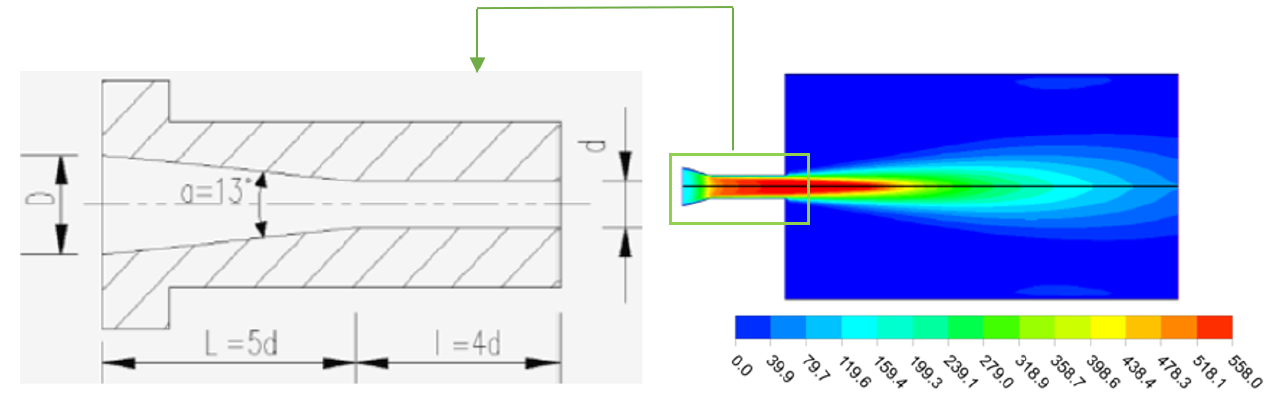
Figure 22. Velocity of water at 30° angle [84].